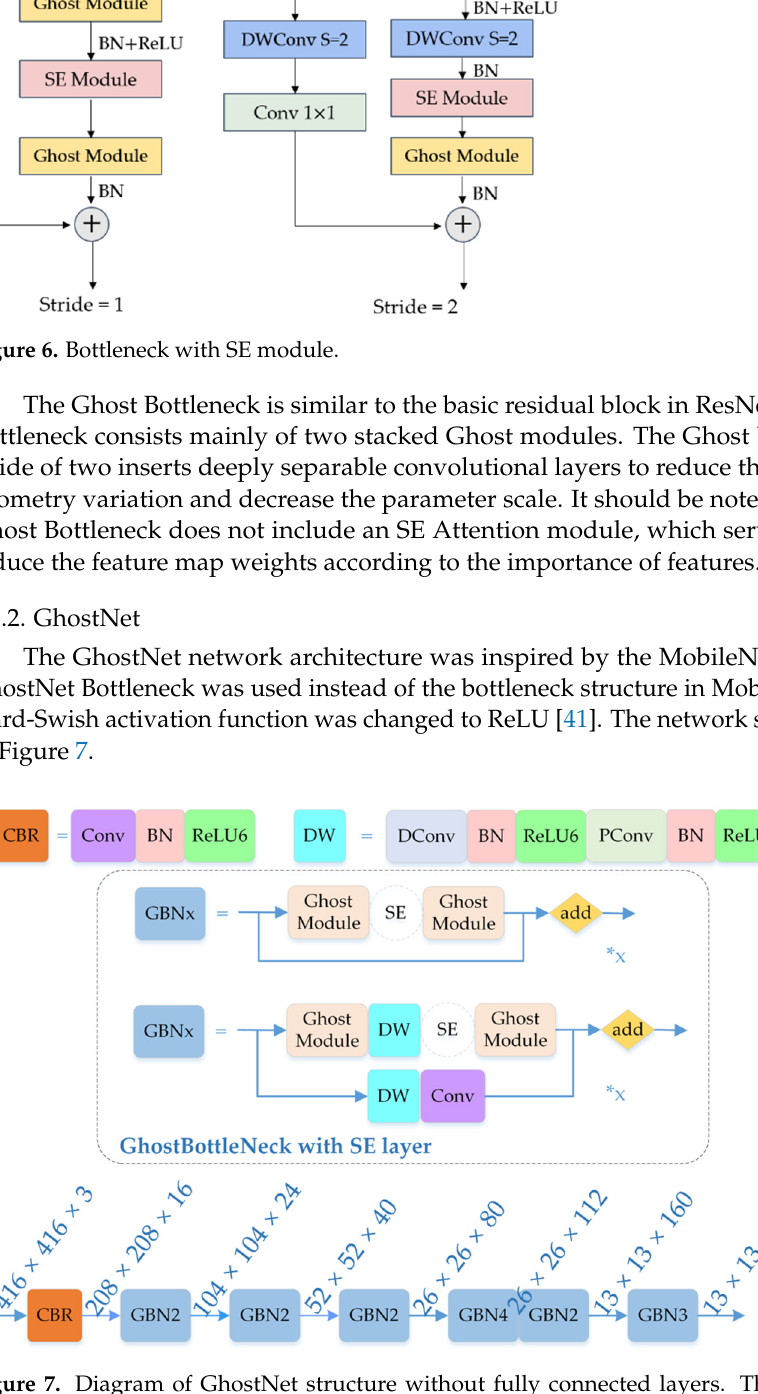
( b ) Figure 8. ( a ) SE Attention structure; and ( b ) Coordinate Attention structure.